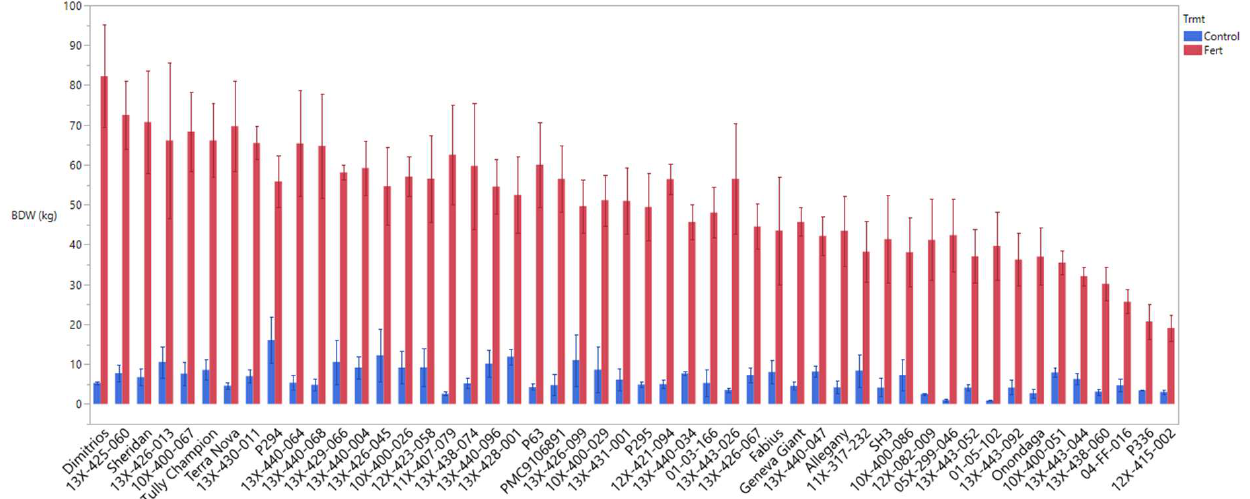
Figure 1. Mean values ( ± standard error) of total aboveground biomass dry weight (BDW) of shrub willow genotypes in greenhouse trial for fertilized treatment (red) and water control (blue).